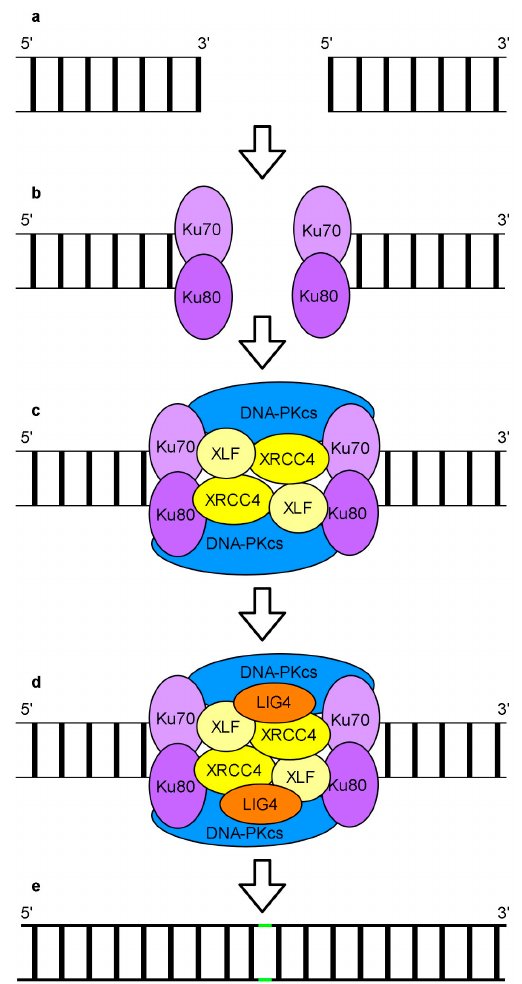
Figure 5. A schematic depiction of canonical NHEJ based on a mammalian model. An example of double-strand breaks (DSBs) with two blunt ends ( a ), which interact with Ku70 / 80 complexes ( b ). Ku70 / 80 recruits DNA-PKcs (DNA dependent protein kinase catalytic subunit) as well as XRCC4 (x-ray cross complementing protein 4) and XLF (XRCC4-like factor), which create a filament between two loose DNA ends ( c ). LIG4 is recruited to ligate the DNA ends ( d ). Ligated DSB ( e